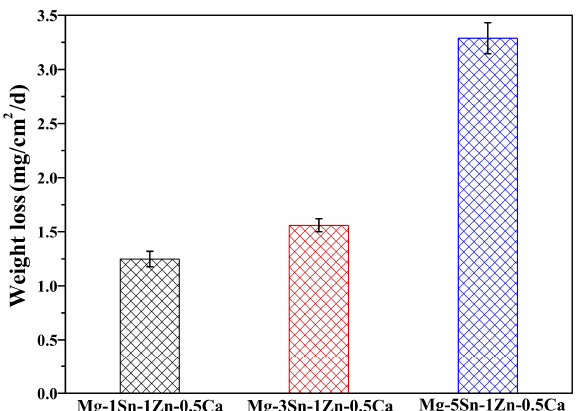
Figure 6. Weight loss rate of Mg–xSn–1Zn–0.5Ca (x = 1, 3 and 5 wt.%) alloys in the Hank’s solution for 7 days.